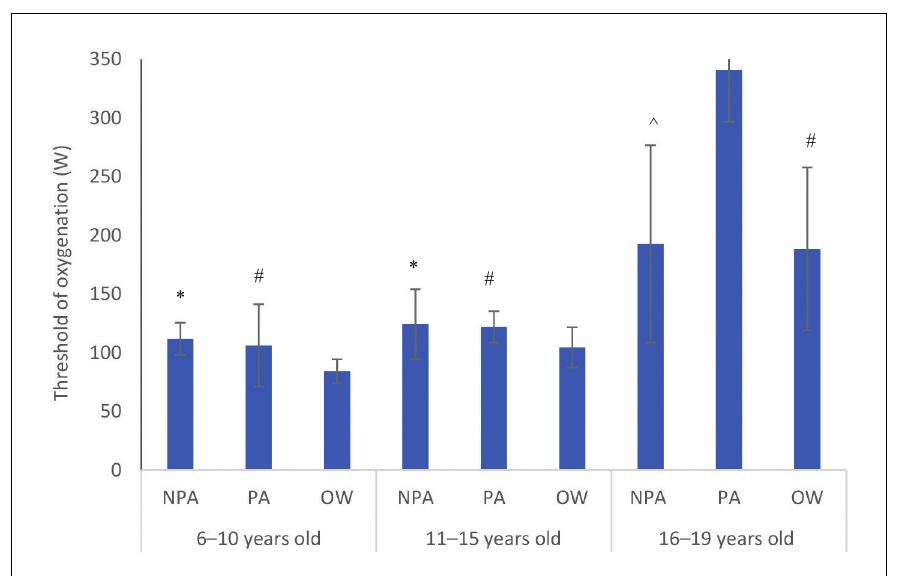
Figure 2. Threshold of